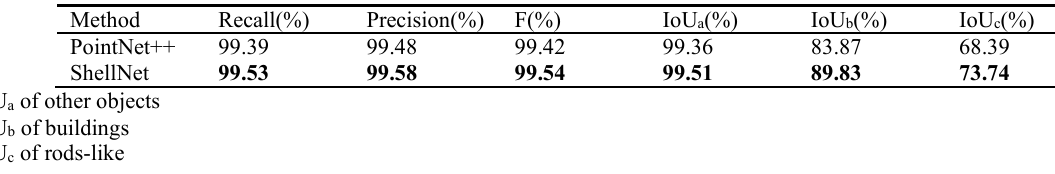
Table 2. Evaluation of the overall segmentation effect of PointNet++ and ShellNet on our